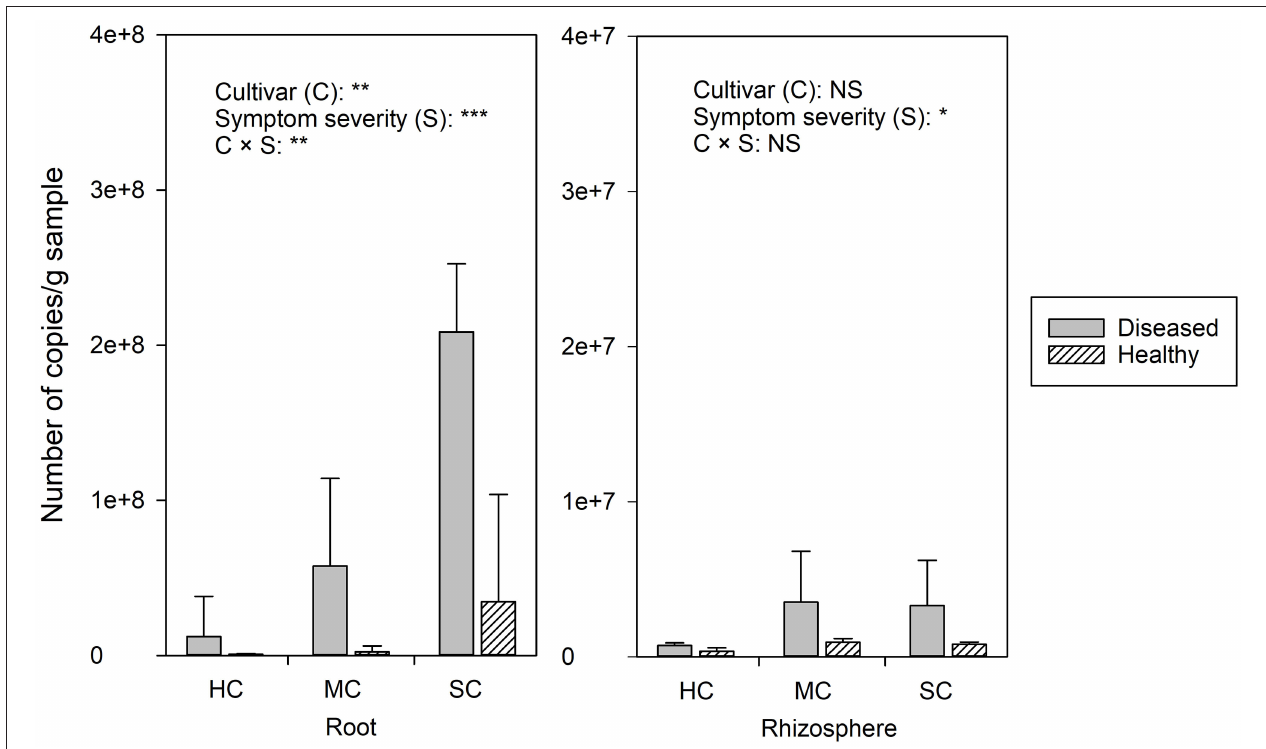
FIGURE 2 | The abundance of Fusarium. oxysporum f. sp. niveum detected by qPCR from watermelon roots and rhizosphere sampled from diseased (D) and healthy (H) watermelon of different cultivars (HC, highly resistant cultivar; MC, moderately resistant cultivar; SC, susceptible cultivar). Significant differences between treatment means according to multiple range test after Bonferroni correction are listed ( n = 5). * P < 0.05; ** P ≤ 0.01; *** P ≤ 0.001; and NS, not statistically